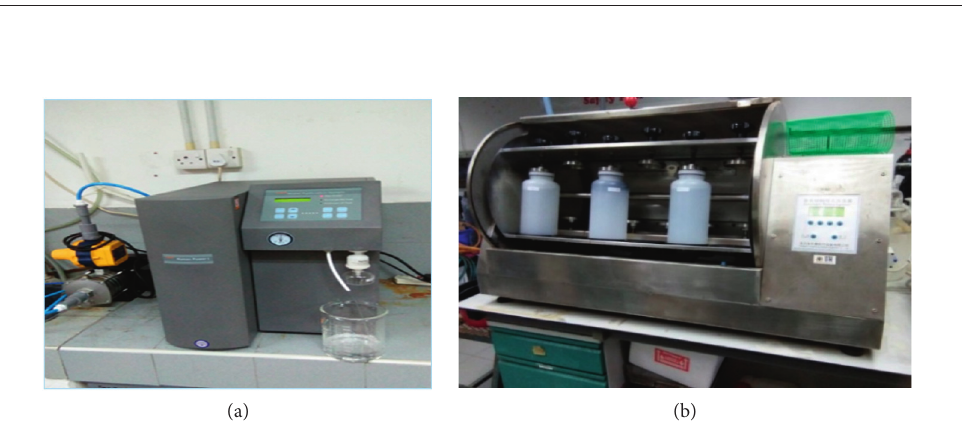
Figure 3: TCLP test assembly. (a) Water purification machine. (b) Automatic rotary